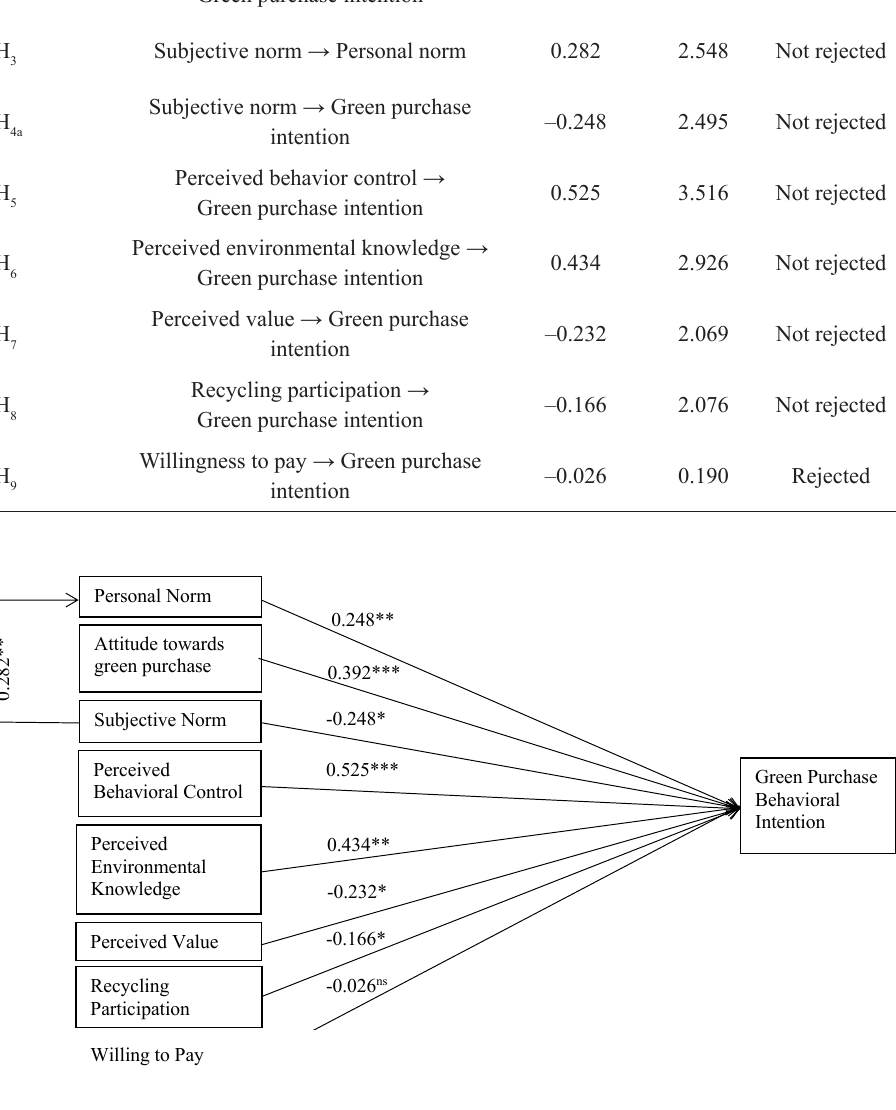
Figure 2. Path analysis